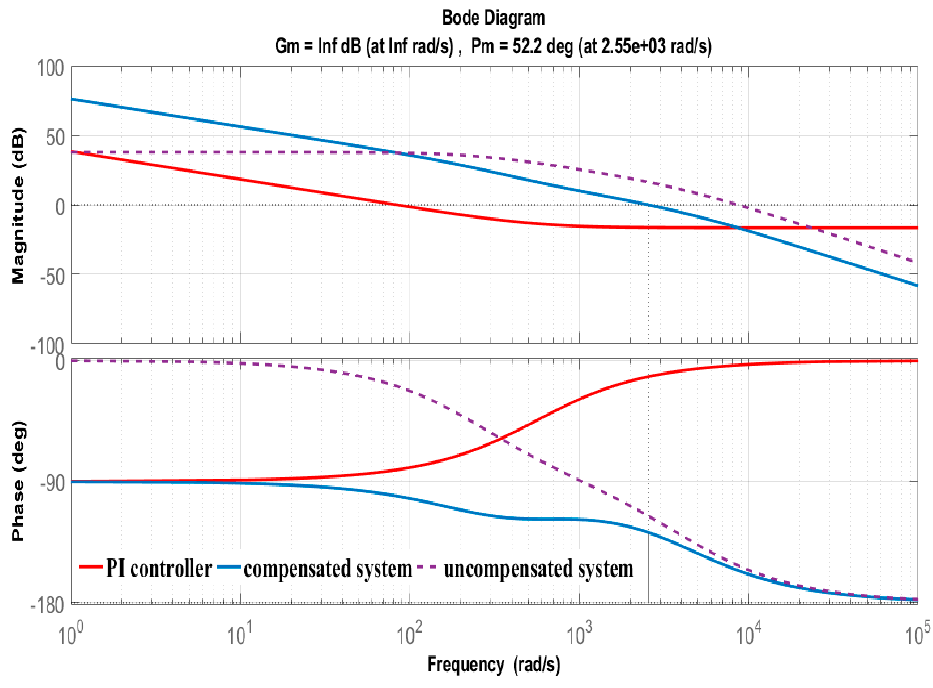
Figure 7. diagram of the PI controller and compensated system.